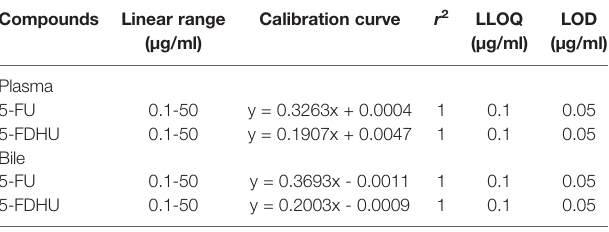
TABLE 1 | Linear ranges, calibration curves, correlation coef fi cients ( r 2 ), and detection limits of 5-FU and FUH 2 using HPLC-UV in the plasma and bile. Compounds Linear range (µg/ml)